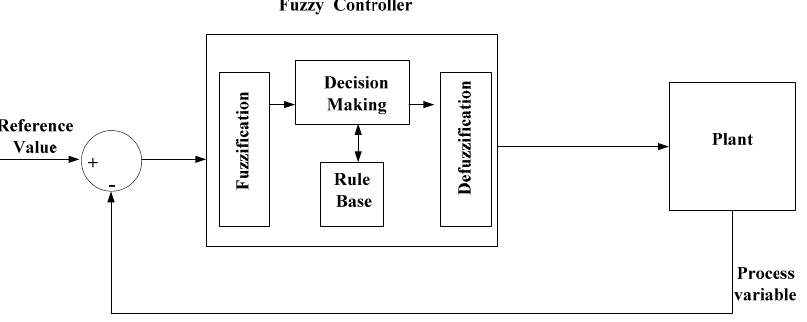
Figure 4. Fuzzy approach system.